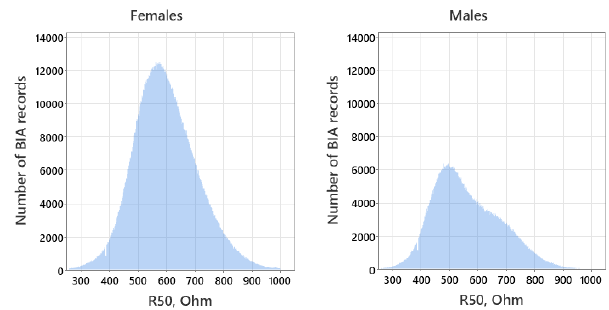
Fig.6: Histograms of the resistances R50: left – females (n=1,607,906), right – males (n=822,071). Histograms of the resistance values at frequency 50 kHz are shown in figure 6. For the subgroup of males,